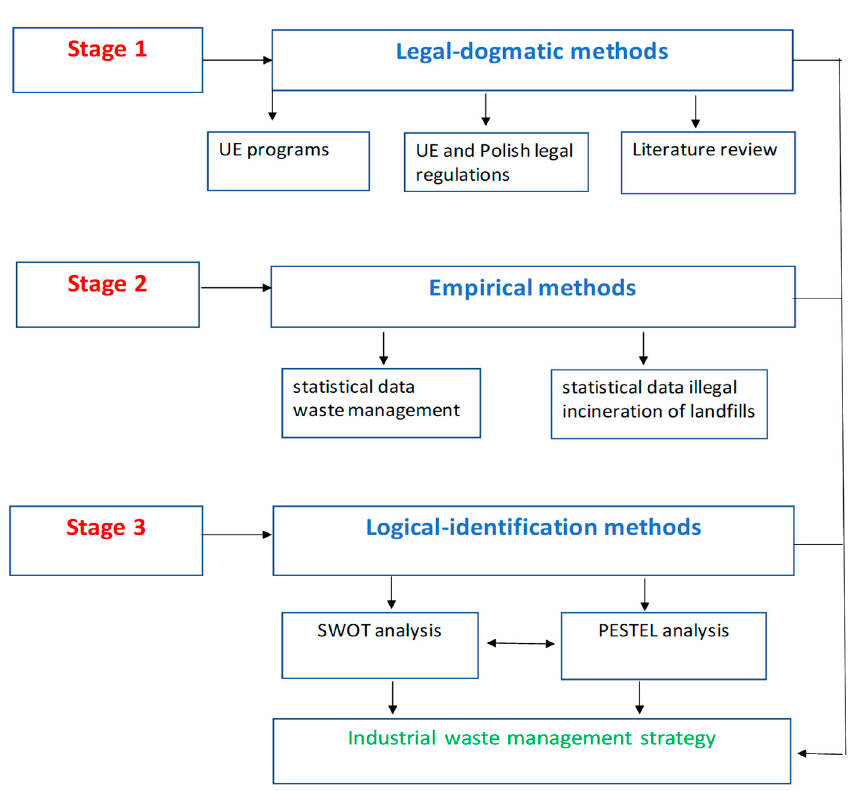
Figure 1. Types of methods used to verify research assumptions.